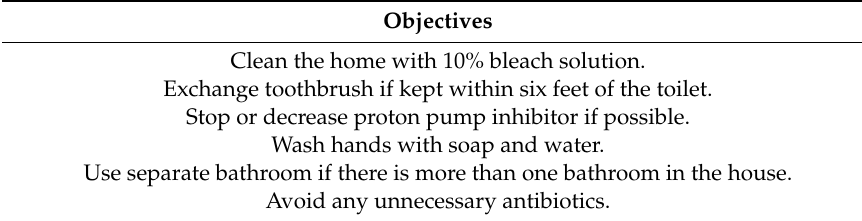
Table 2. Education provided in clinic for recurrent Clostridioides di ffi cile